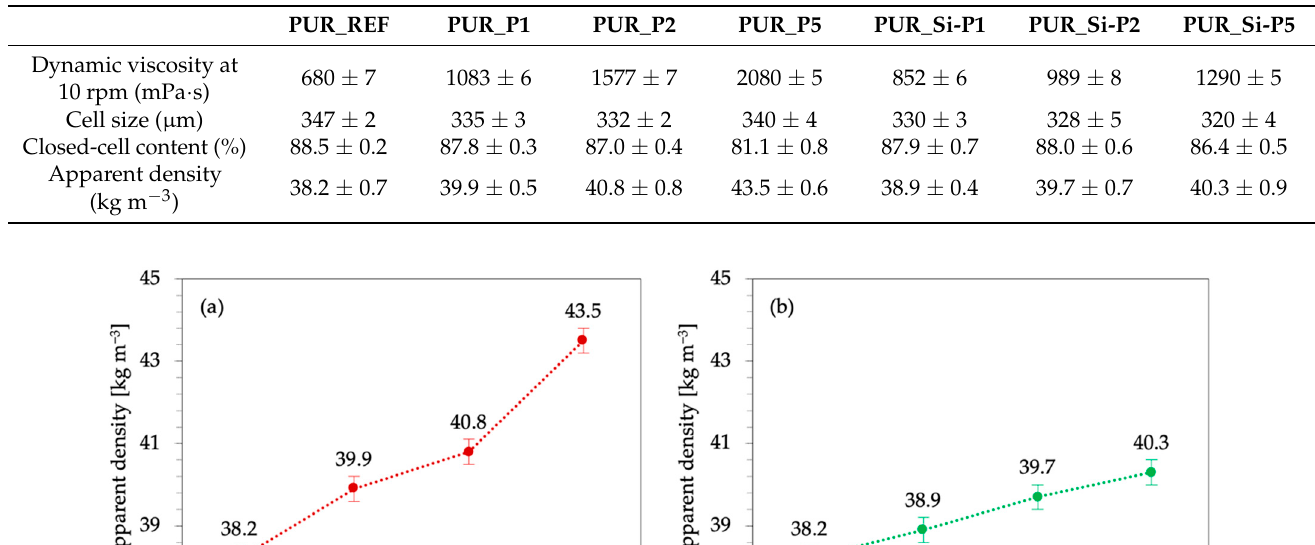
Table 1. Rheological and structural properties of polyurethane foams.